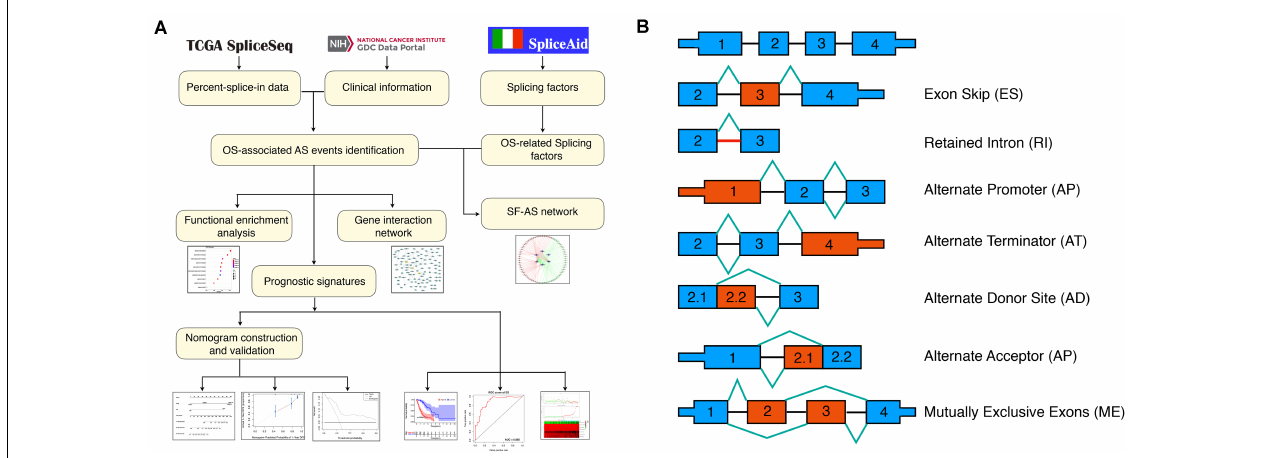
FIGURE 1 | Flowchart of the present study and splicing pattern of AS events. (A) Study flowchart. (B) Illustrations for seven types of AS events, including exon skip (ES), retained intron (RI), alternate promoter (AP), alternate terminator (AT), alternate donor site (AD), alternate promoter (AP), mutually exclusive exons (ME).